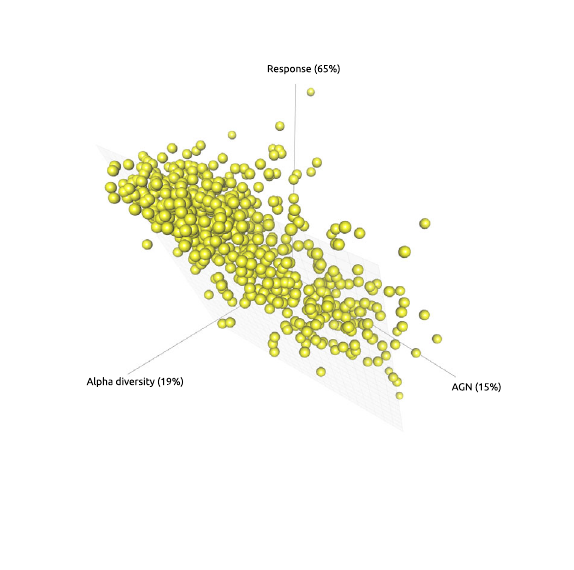
Fig. 5 Relation between the response, baseline alpha diversity and baseline AGN. Scatterplot showing negative relationship between alpha diversity and AGN, AGN and response and positive relationship between alpha diversity and response for baseline samples from all analysed interventions ( n = 641). Variation of data explained by each axis is given in